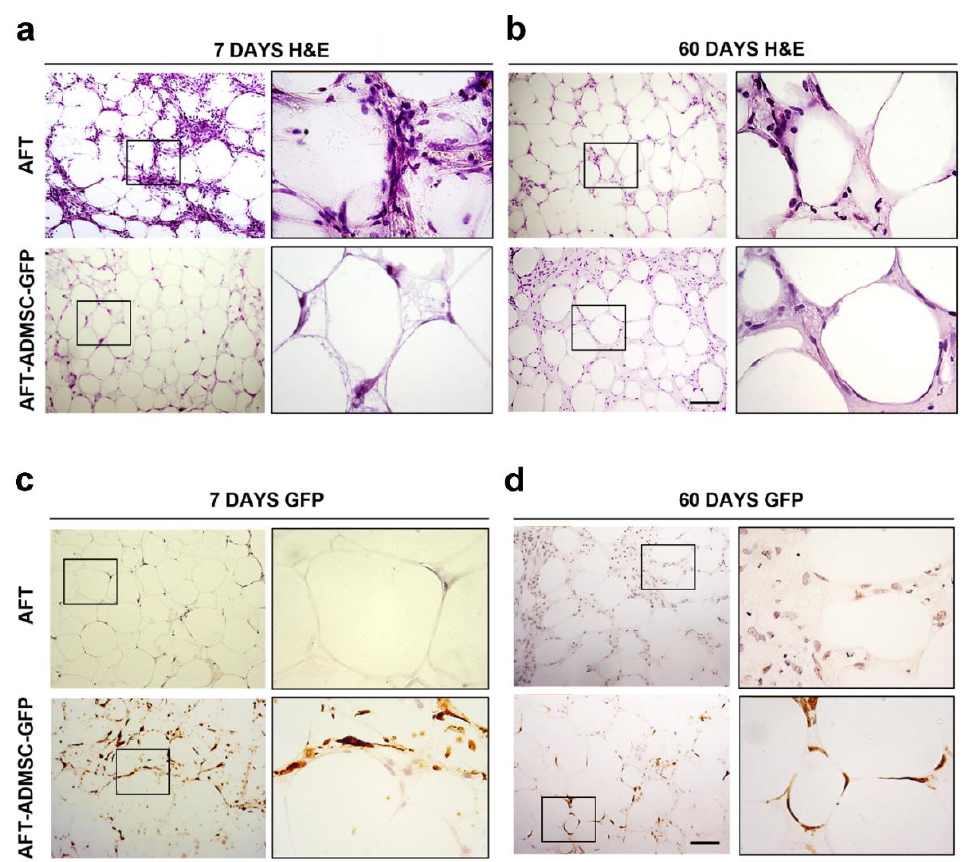
Figure 4. AD-MSC-GFP were tracked in the graft at 7 and 60 days after transplantation. ( a , b ) H&E-stained representative photomicrographs of AFT (upper panel and inset) and an AFT-ADMSC–GFP specimens (bottom panel and inset) at 7 days post-engraftment and 60 days post-engraftment, respectively. ( c ) Immunohistochemistry of GFP staining of specimen (upper panel and inset) and AFT-ADMSC-GFP specimens (bottom panel and inset) at 7 days post-engraftment; the AFT samples were negative for GFP staining. On the contrary, the AFT-ADMSC-GFP positive cells were tracked in the thin layer of connective tissue among the adipocytes cluster. ( d ) Immunohistochemistry GFP staining of AFT (upper panel and inset) and AFT-ADMSC-GFP specimens (bottom panel and inset) at 60 days post-engraftment. The AFT samples were negative for GFP staining. On the contrary, the AFT-ADMSC-GFP specimens were positive. Scale bar = 100 µm.